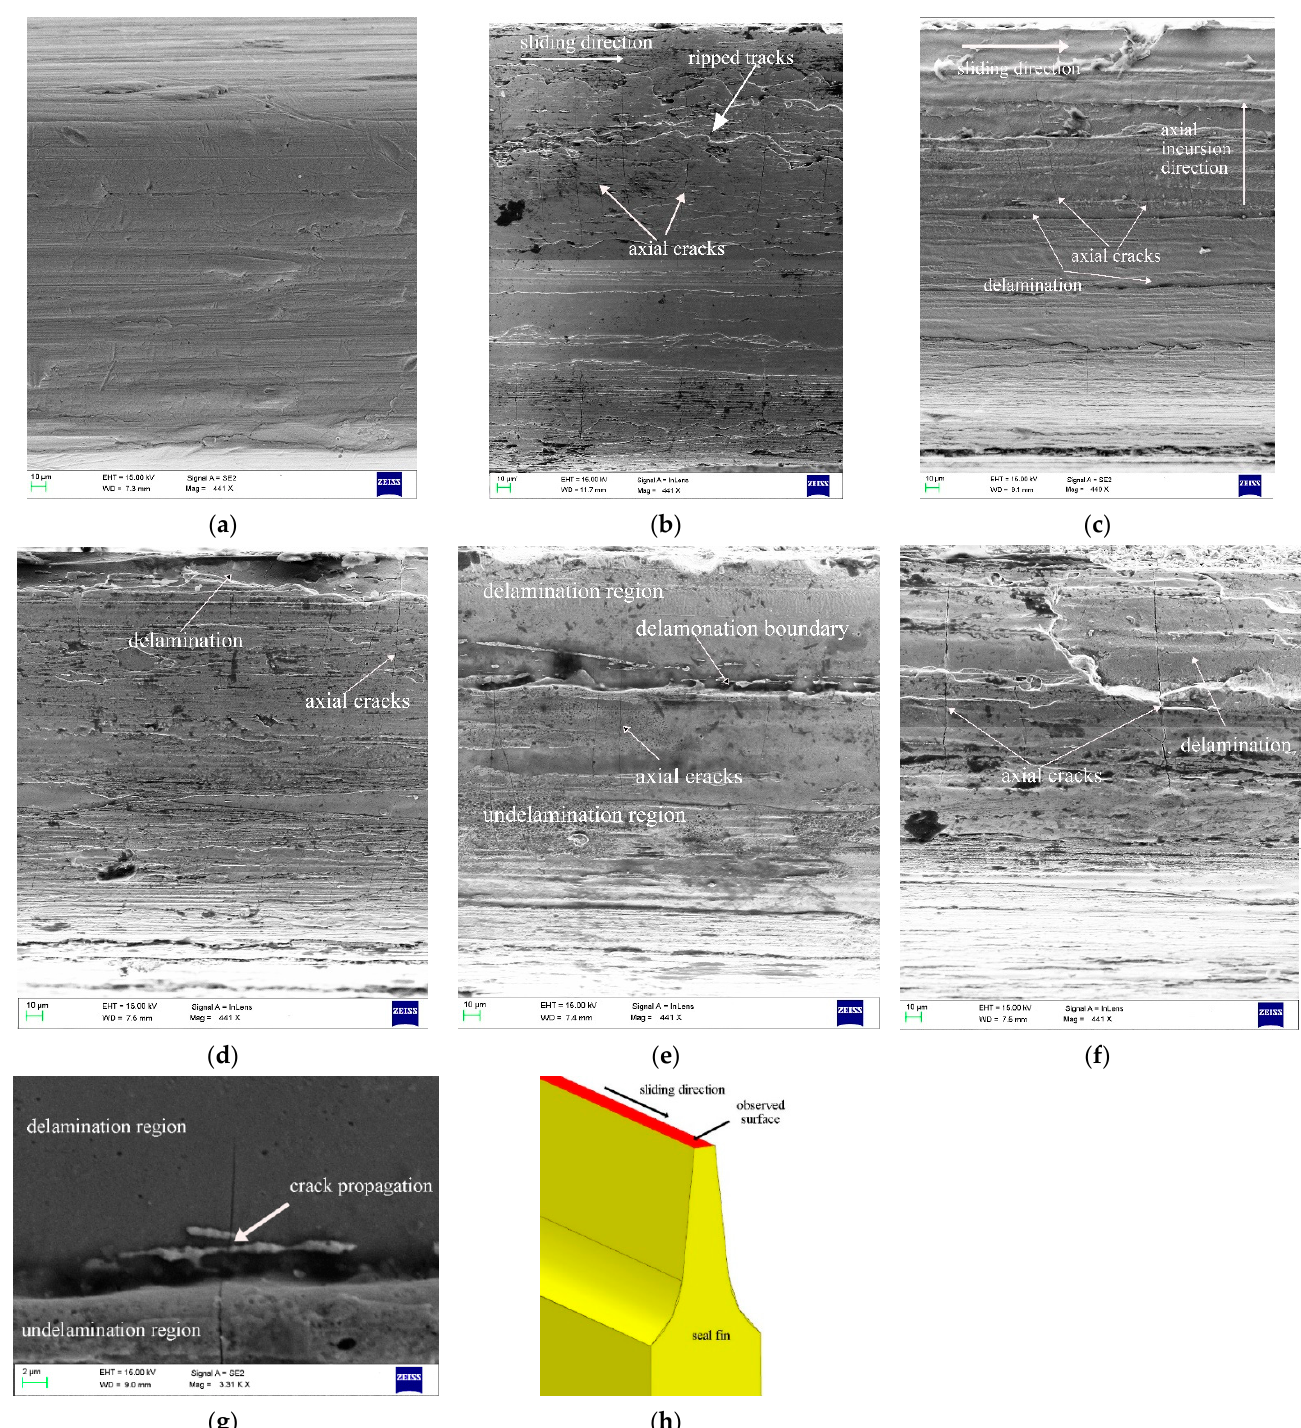
Figure 11. The worn morphology of the seal fin observed by SEM. ( a ) The original seal fin; ( b ) 0 μ m/s; ( c ) 60 μ m/s; ( d ) 80 μ m/s; ( e ) 100 μ m/s; ( f ) 120 μ m/s; ( g ) the partial enlargement figure of ( e ); ( h ) the observed surface; ( a , b ) are cited from reference [16].